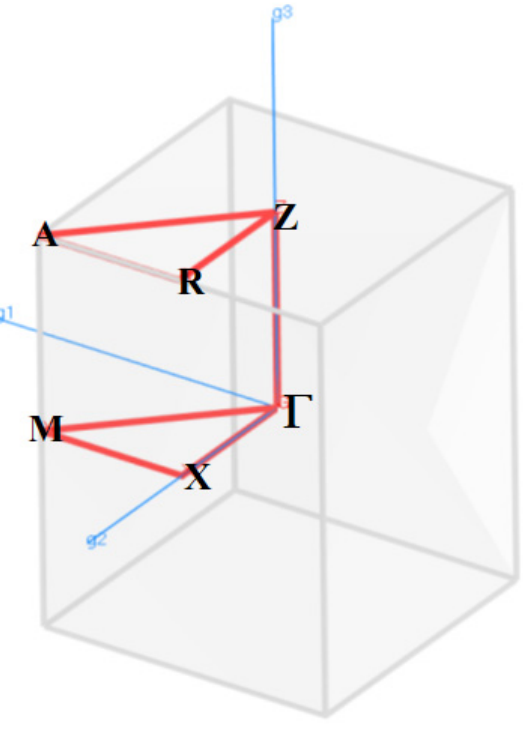
Figure 3. Brillouin zone of Tetragonal lattice. Path: Γ -X-M- Γ -Z-R-A-Z|X-R|M-A [33].